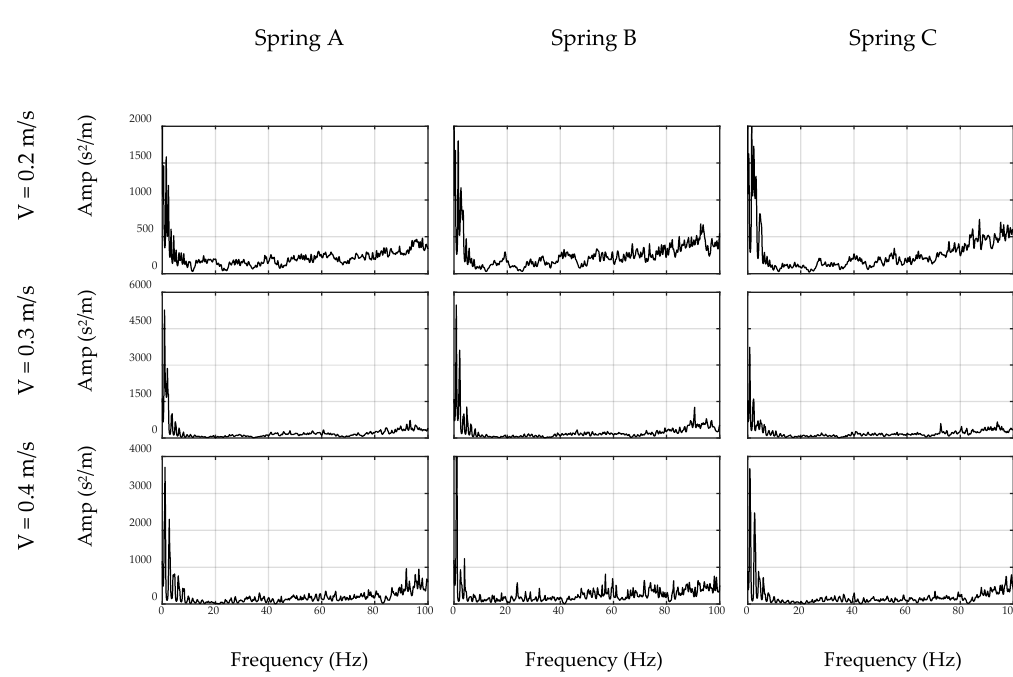
Figure 13. ADFT spectrums of off-bridge signals recorded by smartphone.